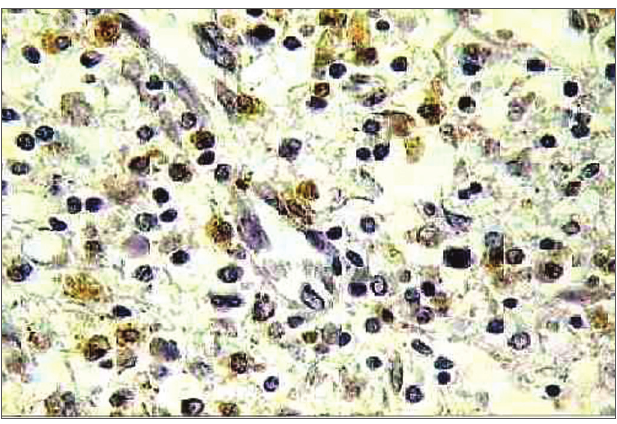
Figura 4. Histopatologia de pólipo nasossinusal eosinofílico tratado com mitomicina C e incubado por 12 horas (TUNEL 400x). (SPSS), versão 17.0 (SPSS. Inc, Chicago, IL, USA) e The